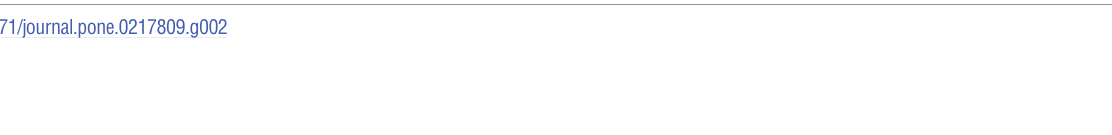
PLOS ONE | https://doi.org/10.1371/journal.pone.0217809 December11,